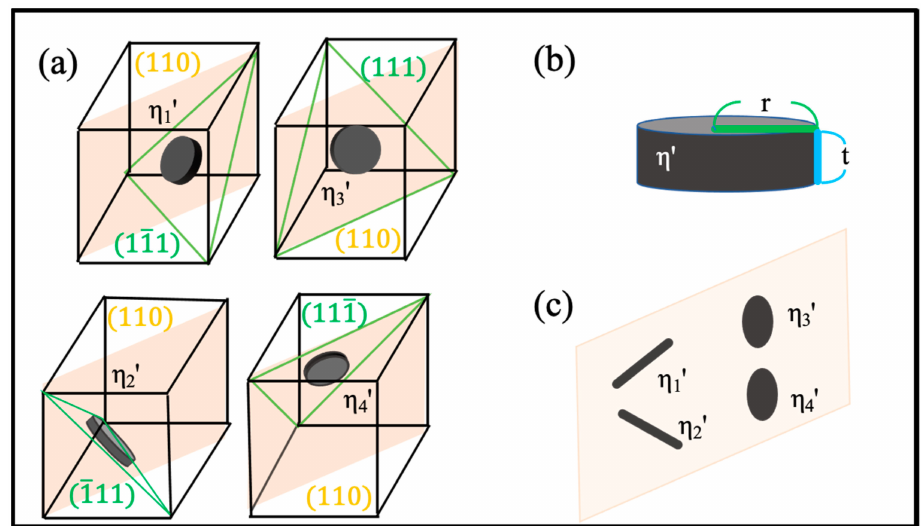
Figure 1. Illustration of orientation relationships of four variants of η (cid:48) : ( a ) η (cid:48) (in blue) on the {111} Al habit planes, with the observed (110) Al planes in orange; ( b ) the presumed circular plate-like morphology of η (cid:48) (the thickness denoted as t, and the radius, r); ( c ) along the [110] Al zone axis, two of the η (cid:48) being edge on (appearing as thick lines), and the other two η (cid:48) being distorted (appearing as ellipses).